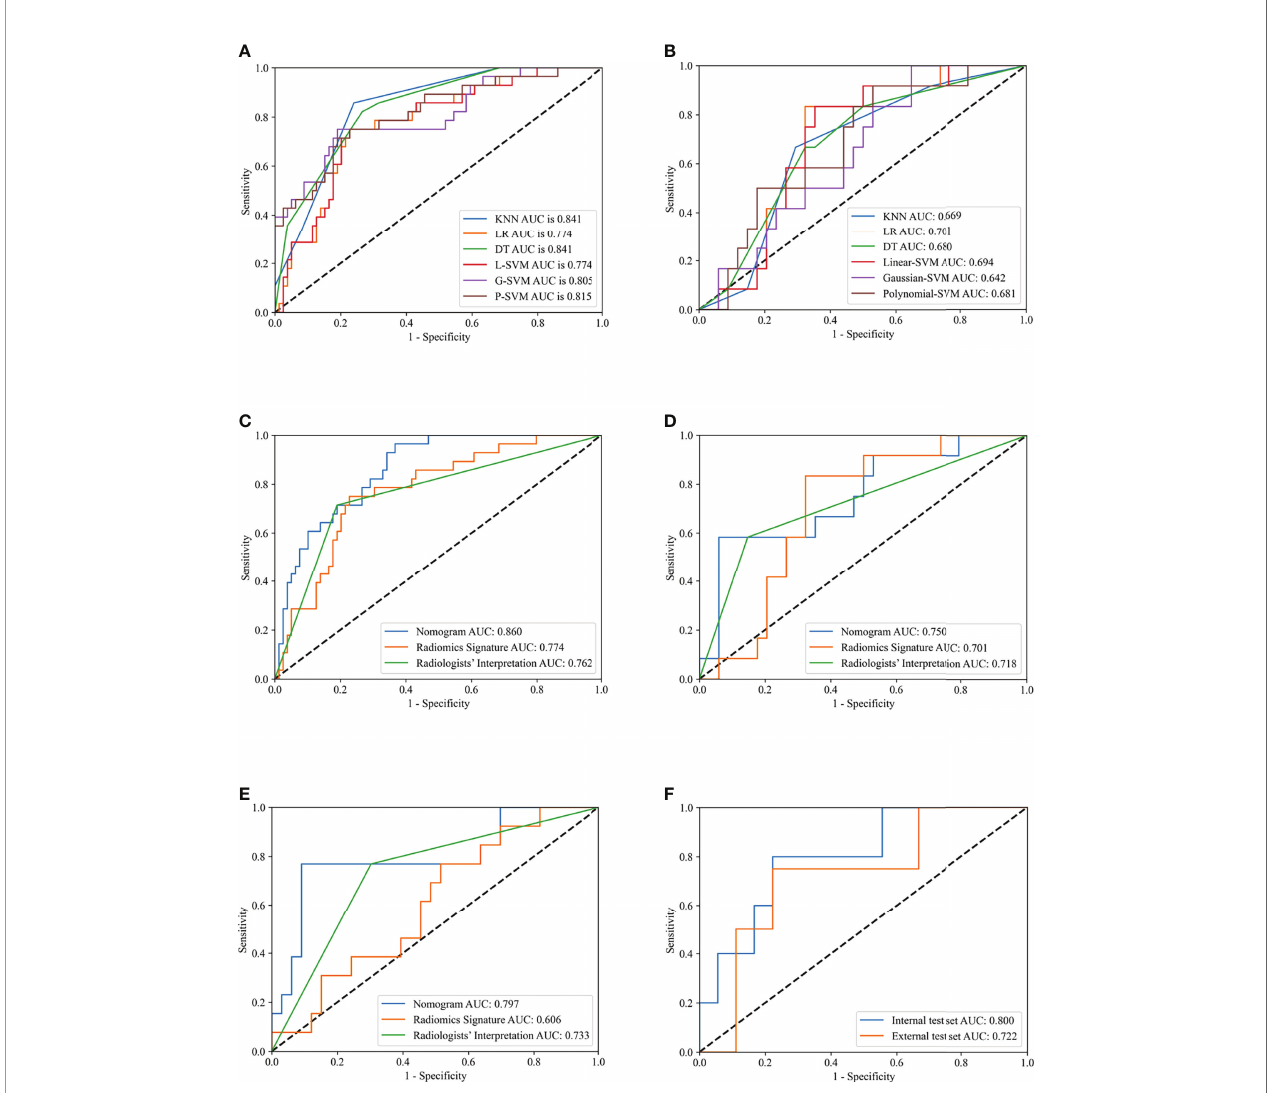
FIGURE 3 | Receiver operating characteristic (ROC) curves of different models in training and test sets. Receiver operating characteristic (ROC) curves of K-Nearest Neighbor (KNN), Logistics Regression (LR), Decision Tree (DT), Linear-support vector machine (Linear-SVM), Gaussian-SVM, and Polynomial-SVM models in the training (A) and internal test (B) set. ROC curves of nomogram, radiomics signature, and radiologists ’ interpretation in the training (C) , internal test (D) , external test (E) set. ROC curves of nomogram for division of minimal and gross extrathyroidal extension (ETE) in the internal test and external test set (F) .